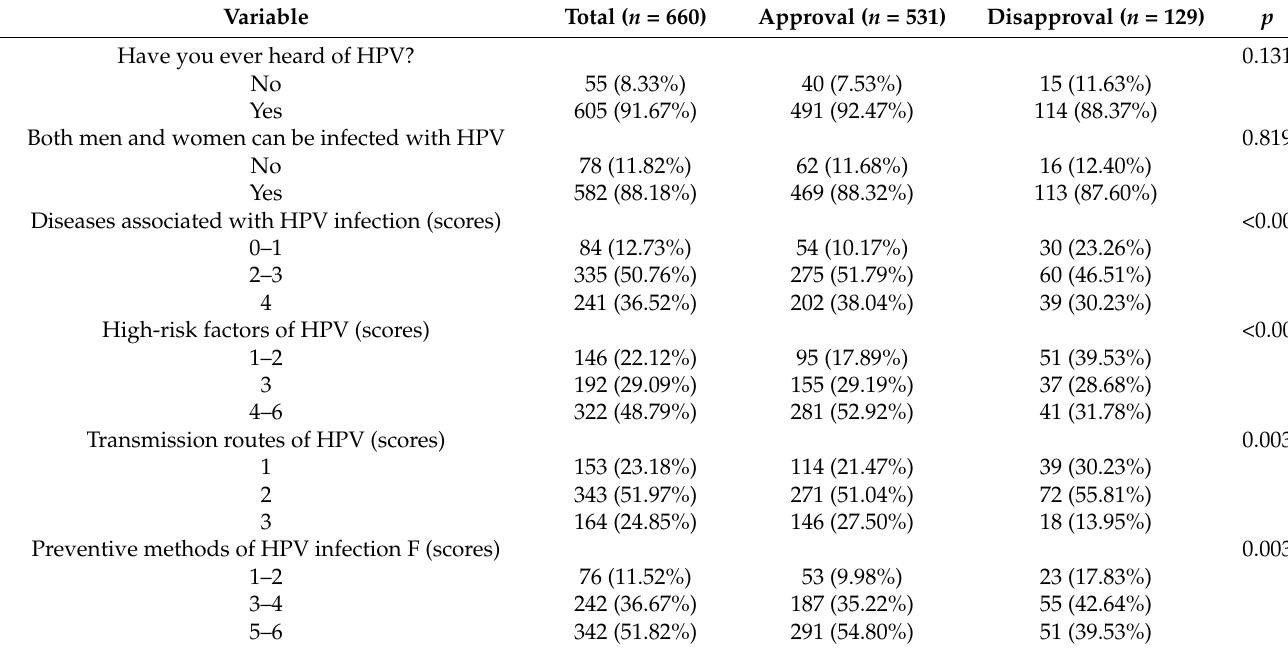
Table 3. Knowledge of HPV.